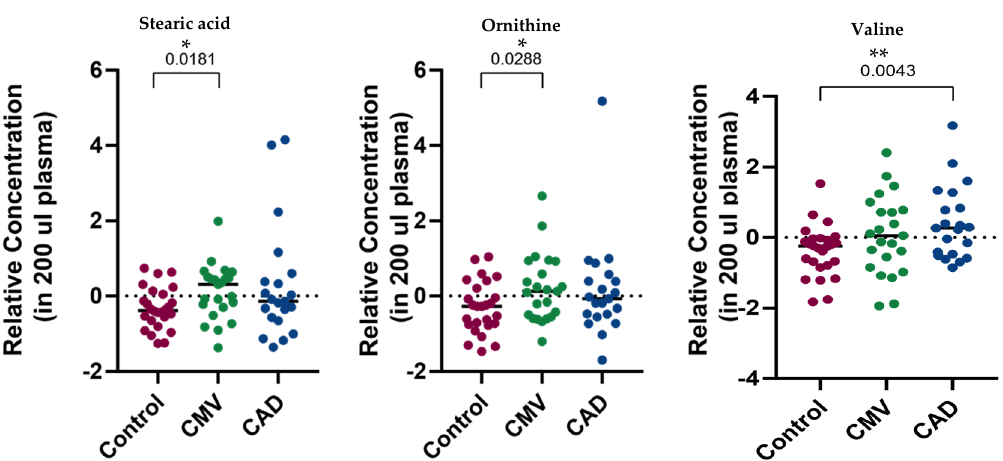
Figure 1. Significantly different metabolites between CMD vs. control and CAD vs. control groups, ( t -test: * p < 0.01, ** p < 0.05).